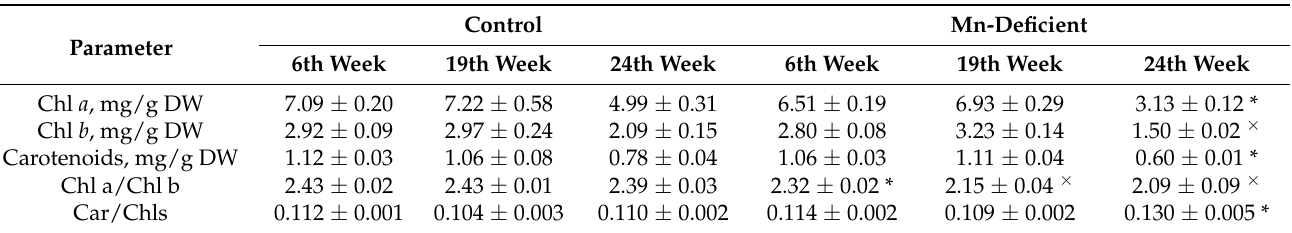
Table 3. Content of photosynthetic pigments.